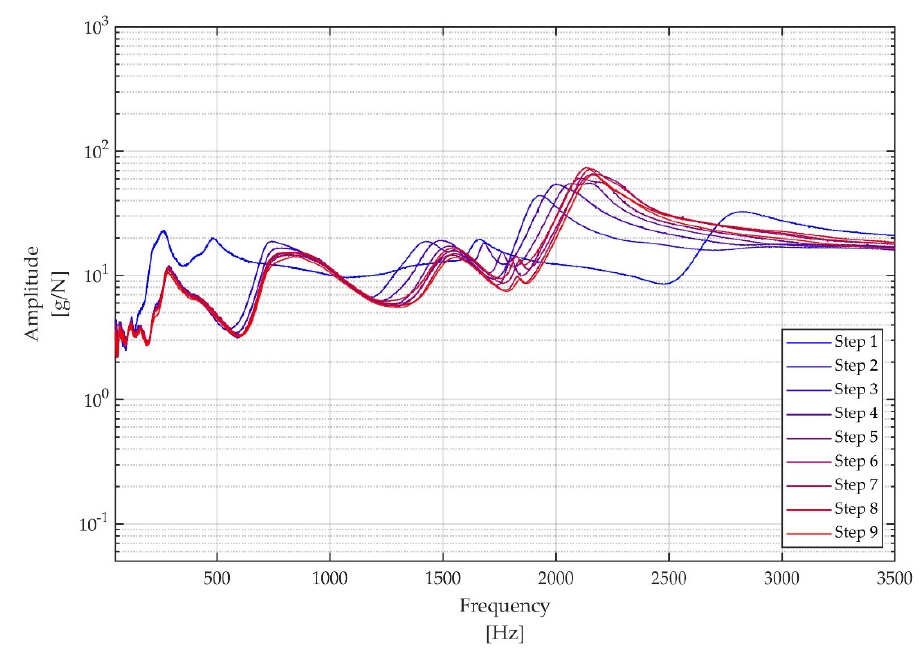
Figure 7. Comparison of FRFs corresponding to subsequent insertion steps with soft tissue in the AP direction.